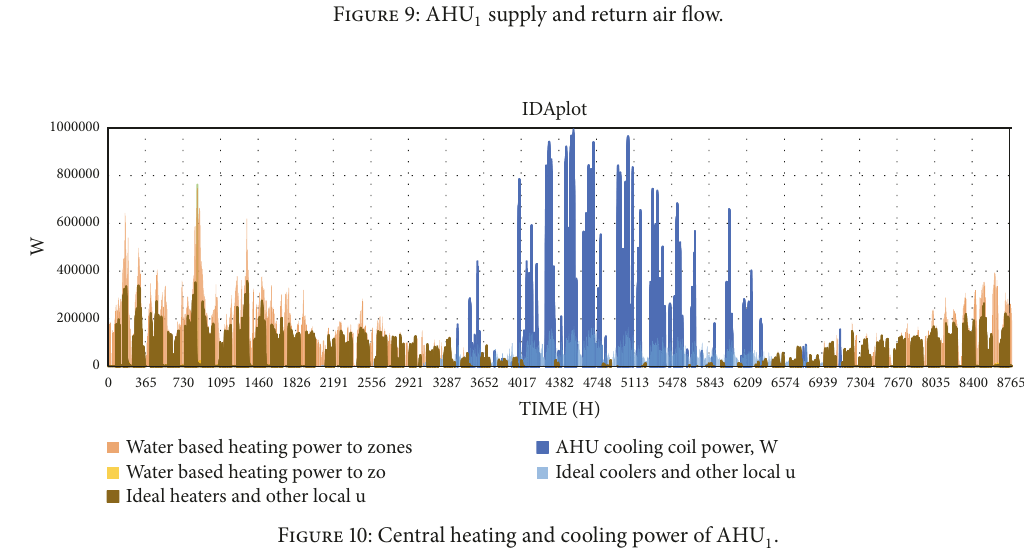
Figure 10: Central heating and cooling power of AHU 1